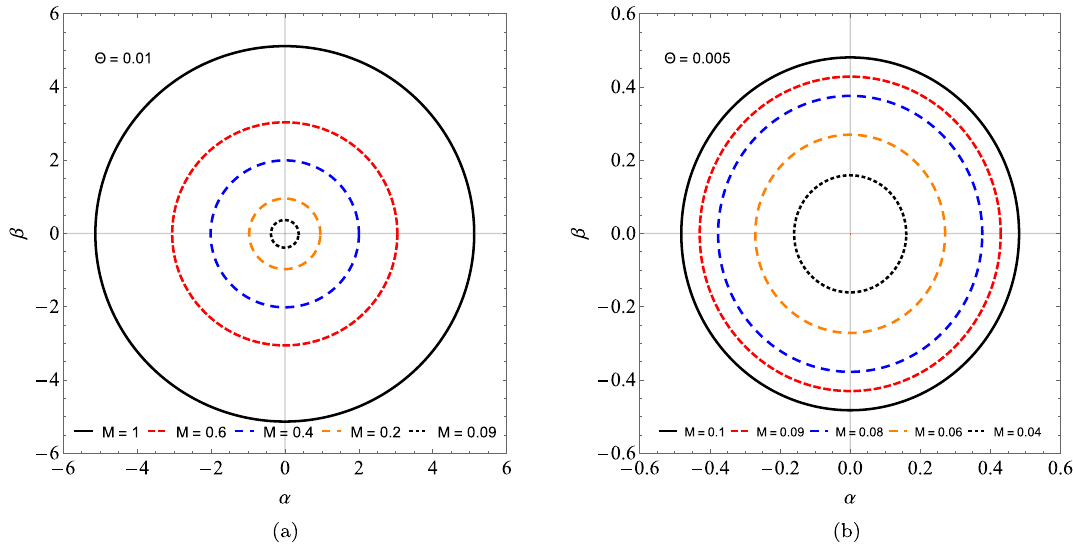
Figure 7. We see the influence of non-commutativity in the shadow admitting ( a ) (cid:31) = 0.01 and M = 1.0, 0.6, 0.4, 0.2, 0.09 . ( b ) (cid:31) = 0.005 and M